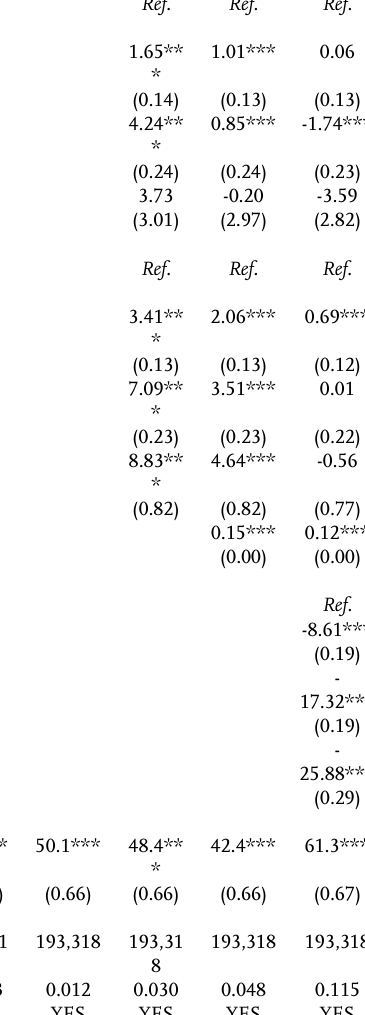
Table A.1 : Earned income, spacing and interaction terms